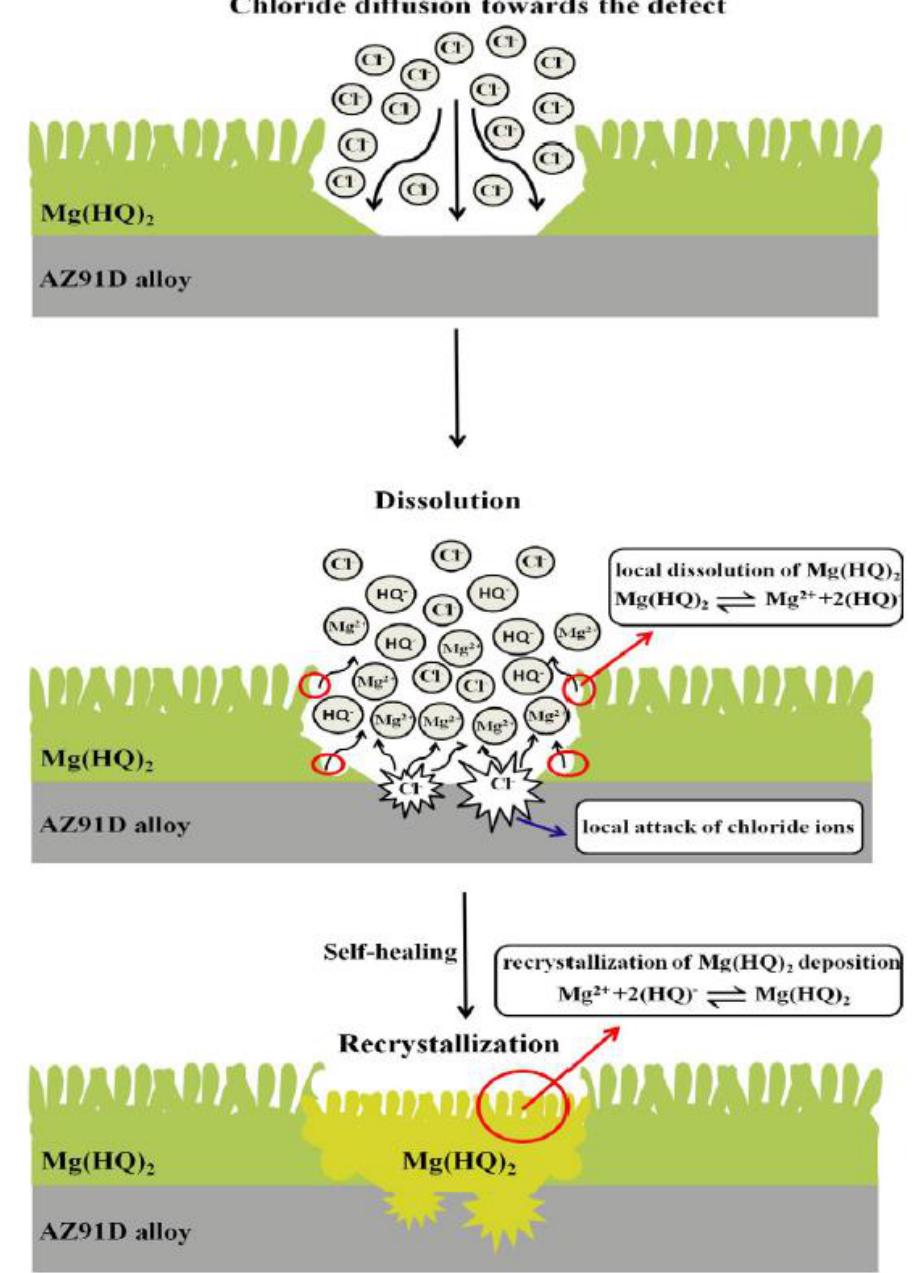
Figure 8. Schematic illustration of inhibition mechanism of 8HQ(Mg) layer on a Mg substrate. Note: Mg(HQ) 2 in the figure and 8HQ(Mg) in the text refer to the same complex. Adapted from [96] with permission from Elsevier.